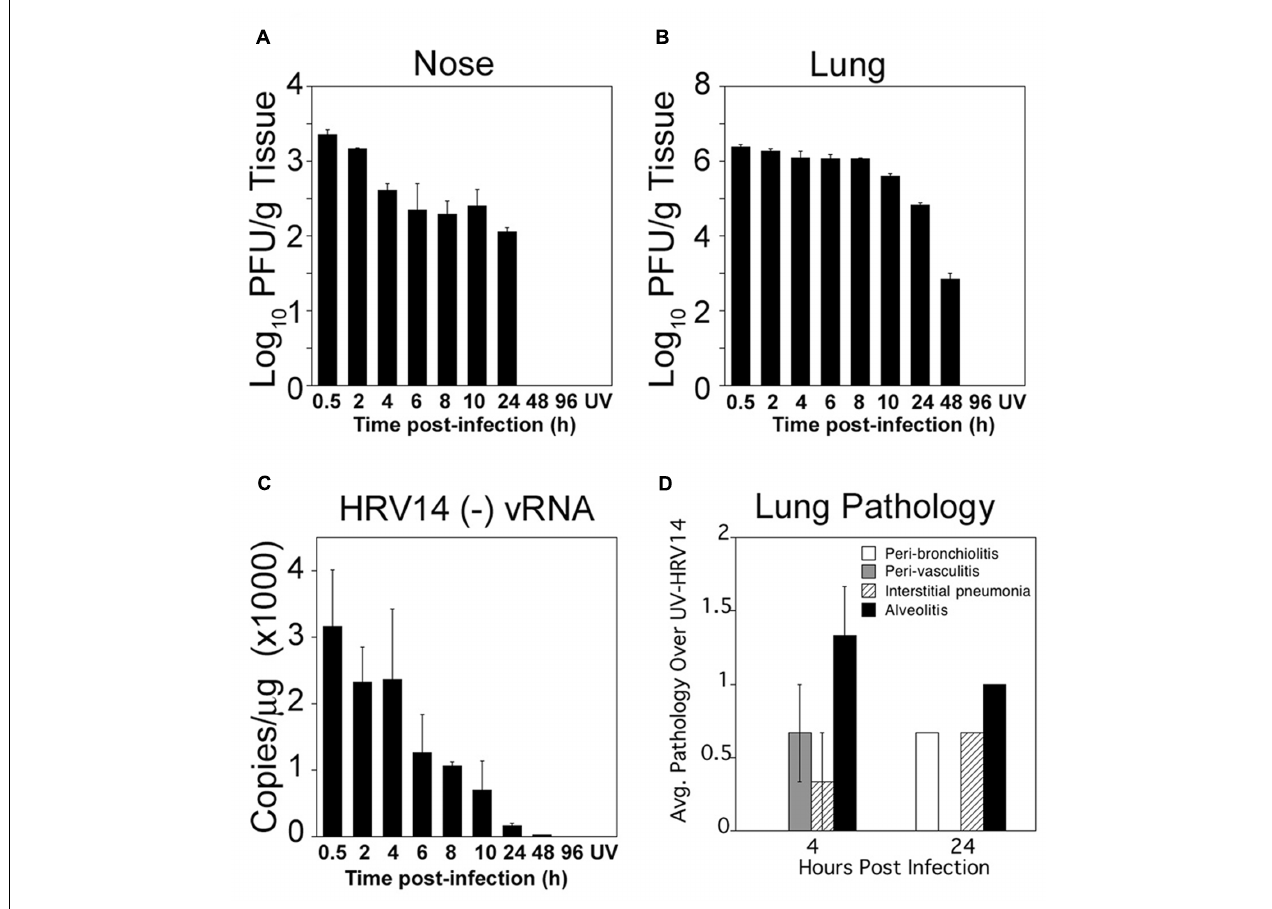
FIGURE 1 | Cotton rat infection with HRV14. Cotton rats were i.n. infected with 10 6 PFU/100 µ l of HRV14. Infectious virus titers in nose (A) , and in lung (B) homogenates from infected animals at the indicated times (h) post-challenge. Groups of three animals were sacrificed at each time point. Results are representative of two independent experiments. Animals inoculated with UV-HRV14 and sacrificed at 4 h p.i. (UV) were shown as control. (C) Quantification of HRV14 (-) vRNA by qRT-PCR in lung tissue at the indicated times p.i. n = 3 per time point and results are representative of two independent experiments. (D) Histopathology scores obtained from lungs of HRV14 infected animals and euthanized at the indicated time p.i. The score of each parameter was plotted for HRV14-infected animals after subtracting the background lung inflammation induced by UV-HRV14 inoculation at each time analyzed. Data is representative of two independent experiments, n =